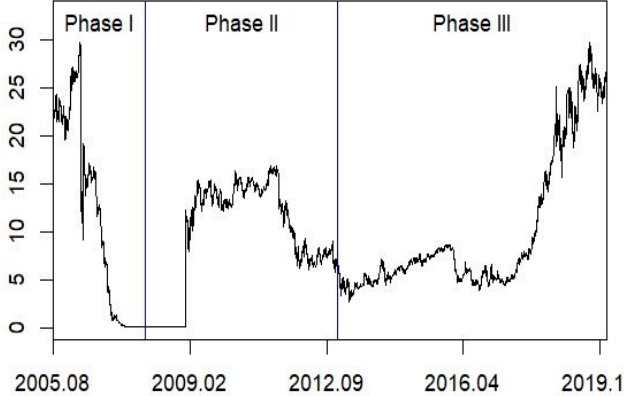
Figure 2. The price dynamics of the EU Allowance Unit (EUA) for each period.